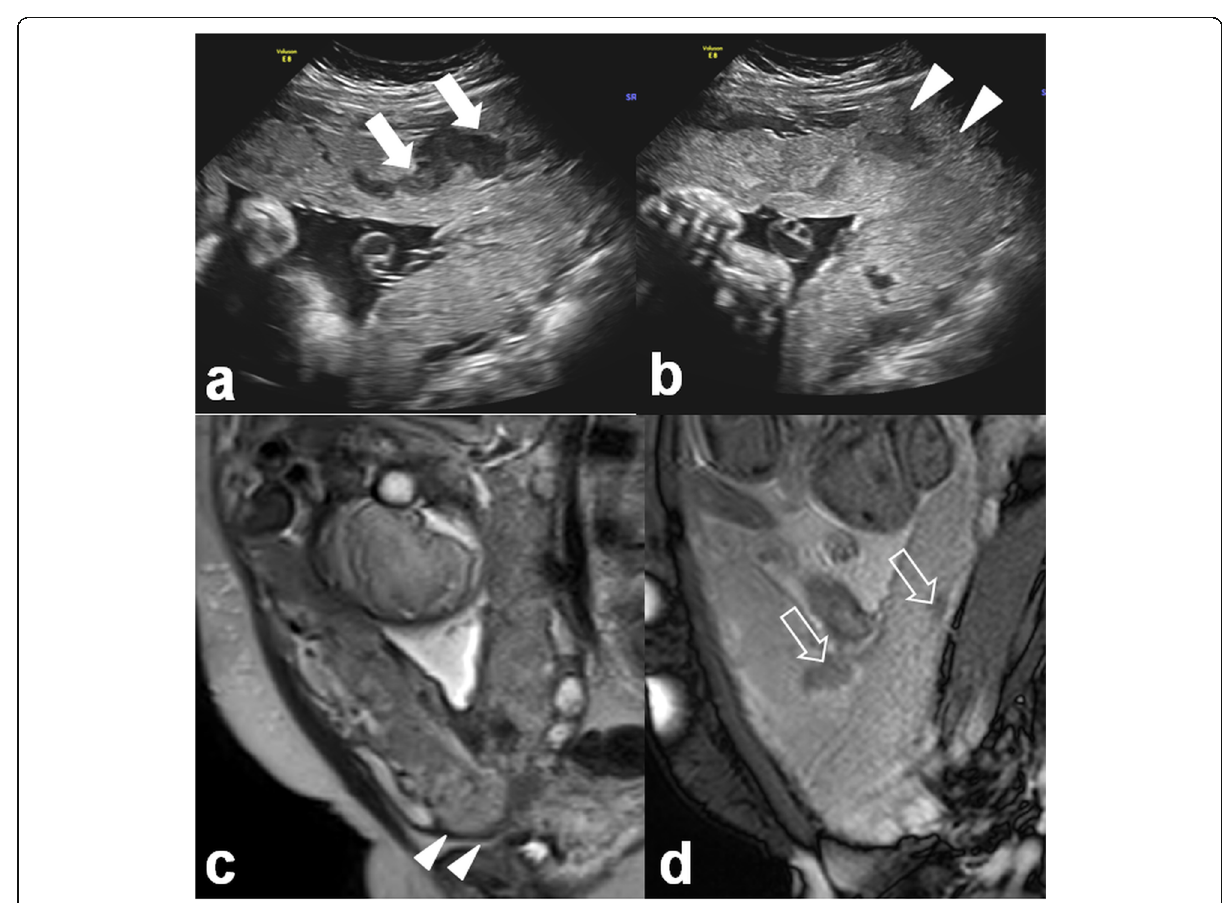
Fig. 1 A 36-year-old woman (gravida − 3) with history of previous Caesarean section. Sonography images ( a , b ) of the placenta show intraplacental venous lakes (arrows) and loss of uteroplacental interface (arrowheads). Sagittal T2 HASTE ( a ) and SSFP ( b ) images show placenta previa with loss of interface and focal bulge (arrowheads), heterogenous placenta and dark bands (open arrows). Elective Caesarean section confirmed placenta accreta and obstetric hysterectomy was